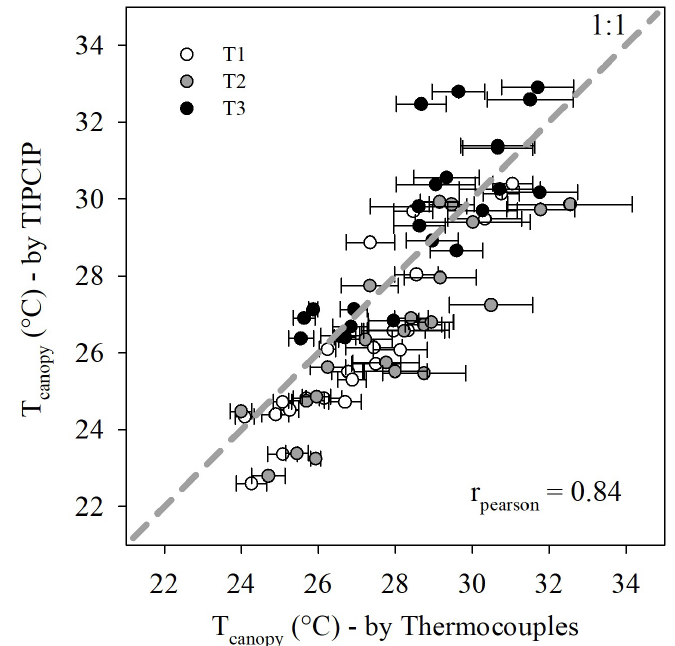
Figure 4. Scatter plot ( ± standard error) of canopy temperatures ( T canopy ) acquired by thermocouples ( x -axis) and infrared thermal images, which were processed with the Thermal Images Processor (TIPCIP) software ( y -axis) under three irrigation treatments: T1 (control or fully irrigated), T2 (crop water stress index (CWSI) < 0.4), and T3 (CWSI < 0.7). The 1:1 dashed line ( x = y ) is plotted as a reference. These data were collected in the first experiment (E1). r Pearson : Pearson correlation